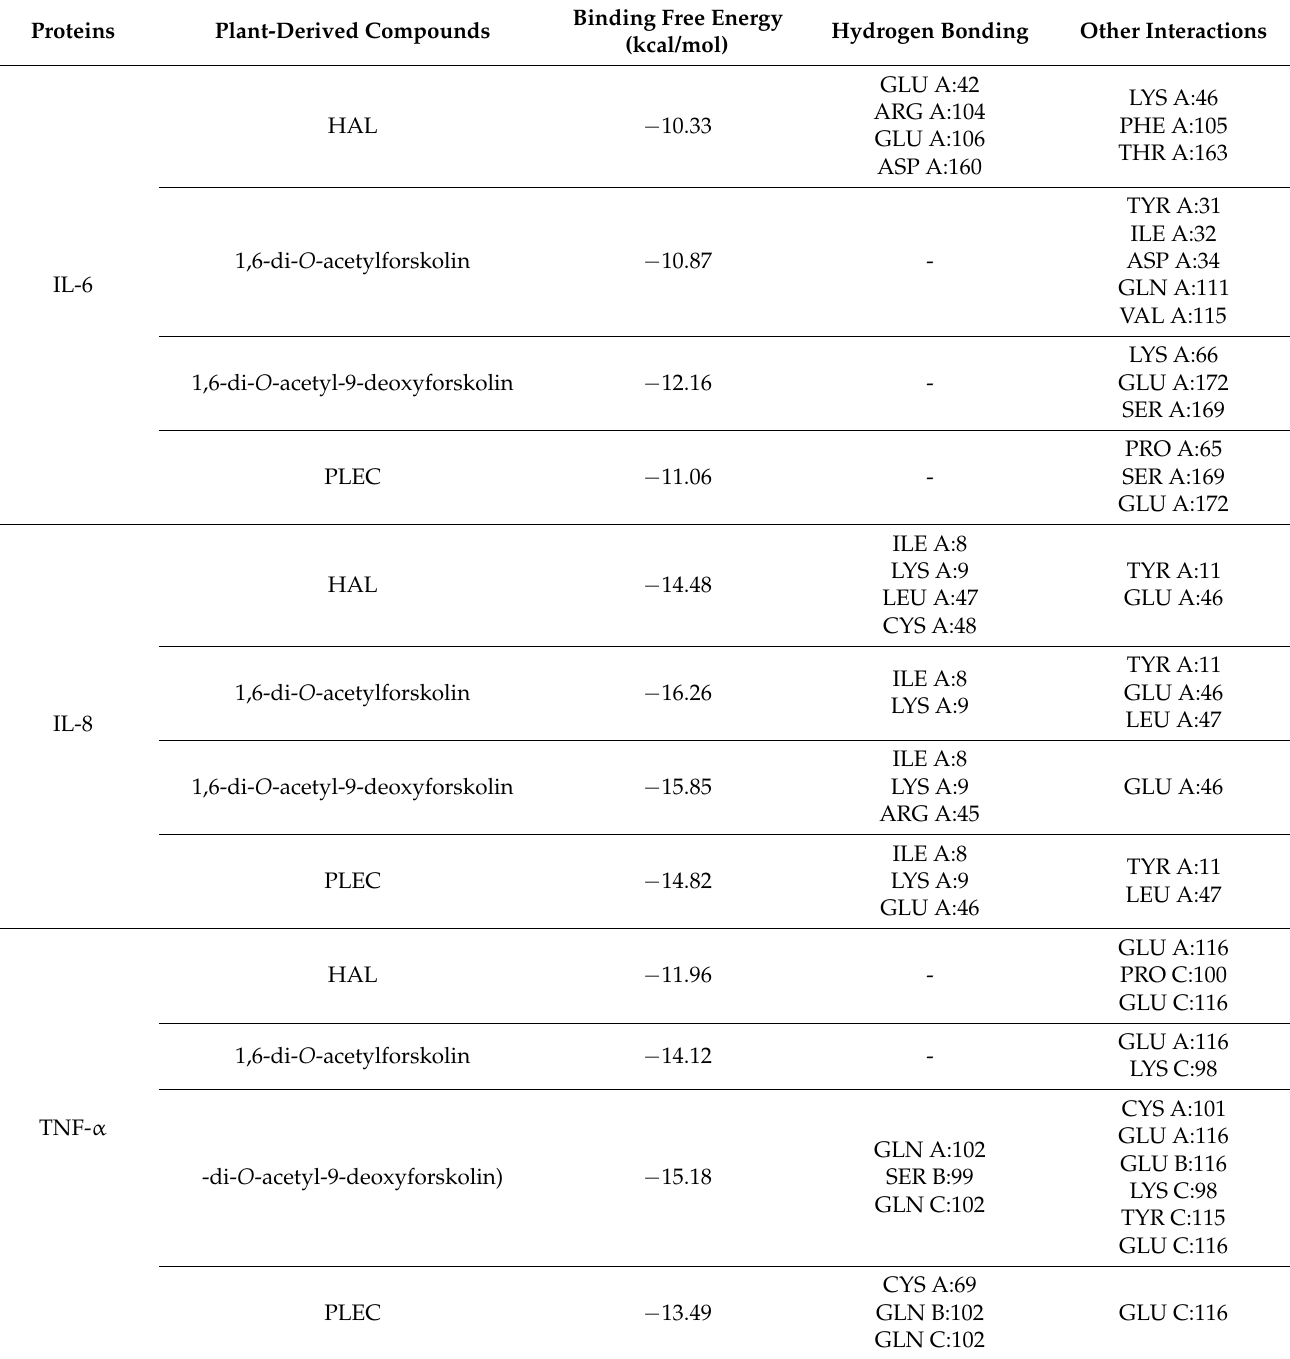
Table 4. Binding energy, hydrogen bonding and other nonbonding interactions in ligands–proteins docking. Proteins Plant-Derived